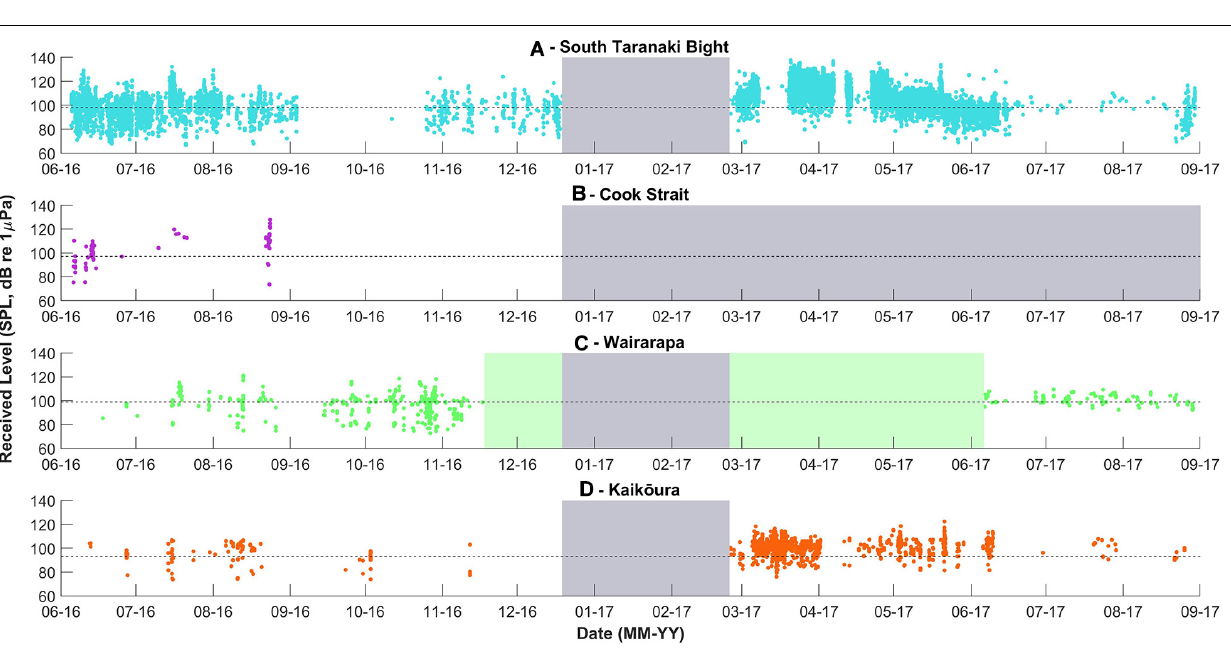
FIGURE 6 | Received levels of pygmy blue whale calls detected per recording location, over time. Received levels were calculated only for unit “B” of each phrase. The dashed lines indicate the detection threshold associated with an unconditional probability of detection of 50%, the model configuration is described in the Methodology. The grey and green blocks are as described in Figure 3